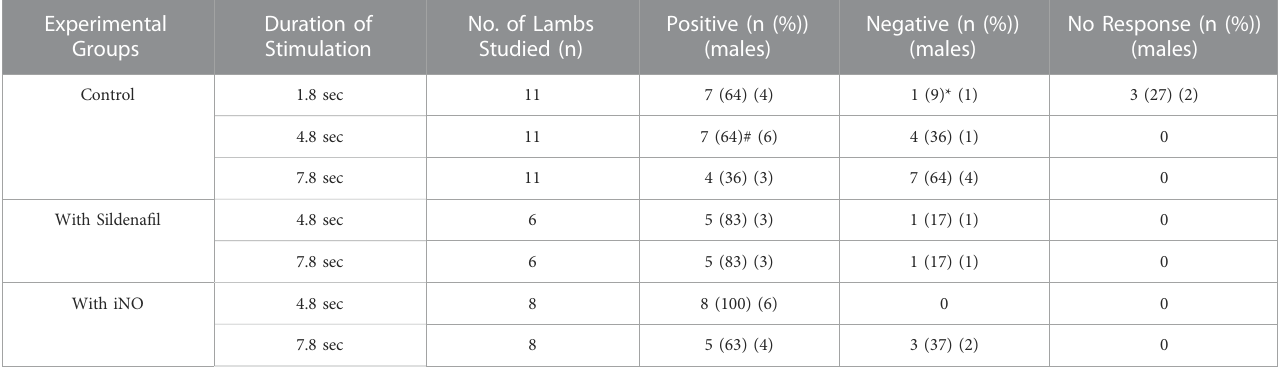
* p < 0.05 for 1.8 vs. 4.8 vs. 7.8 s in controls, # p < 0.05 for control vs. sildena fi l vs. iNO at 4.8 s (chi-square test for